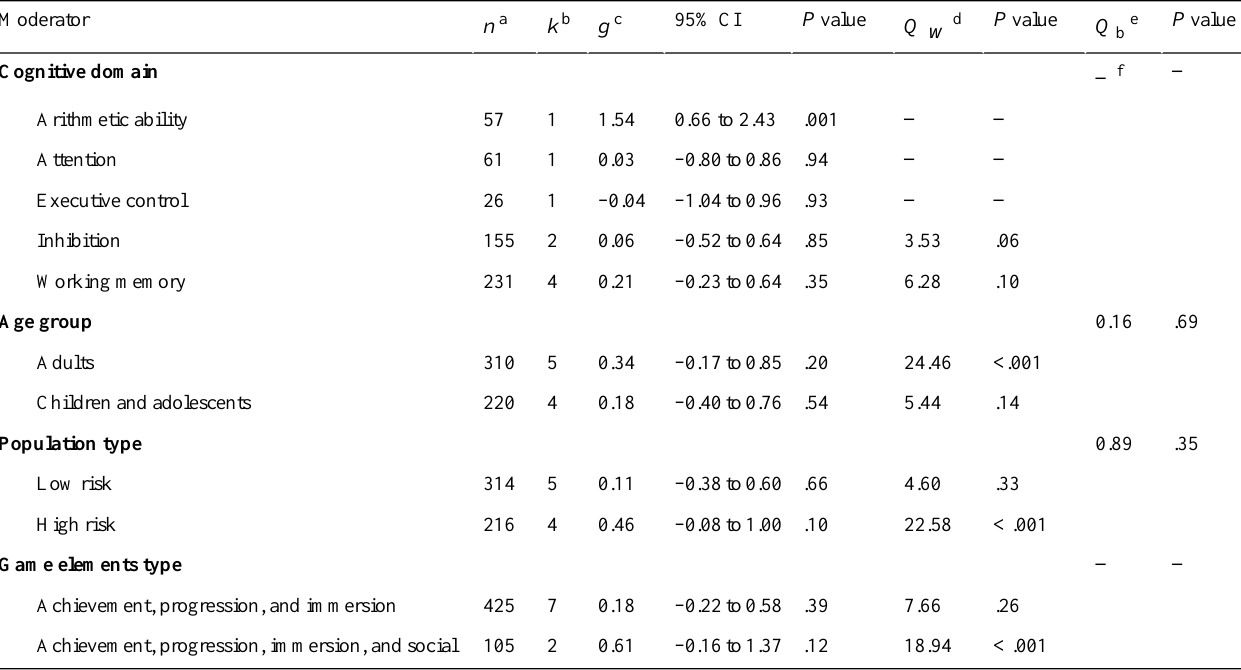
Table 3. Results of the subgroup analyses for cognitive process